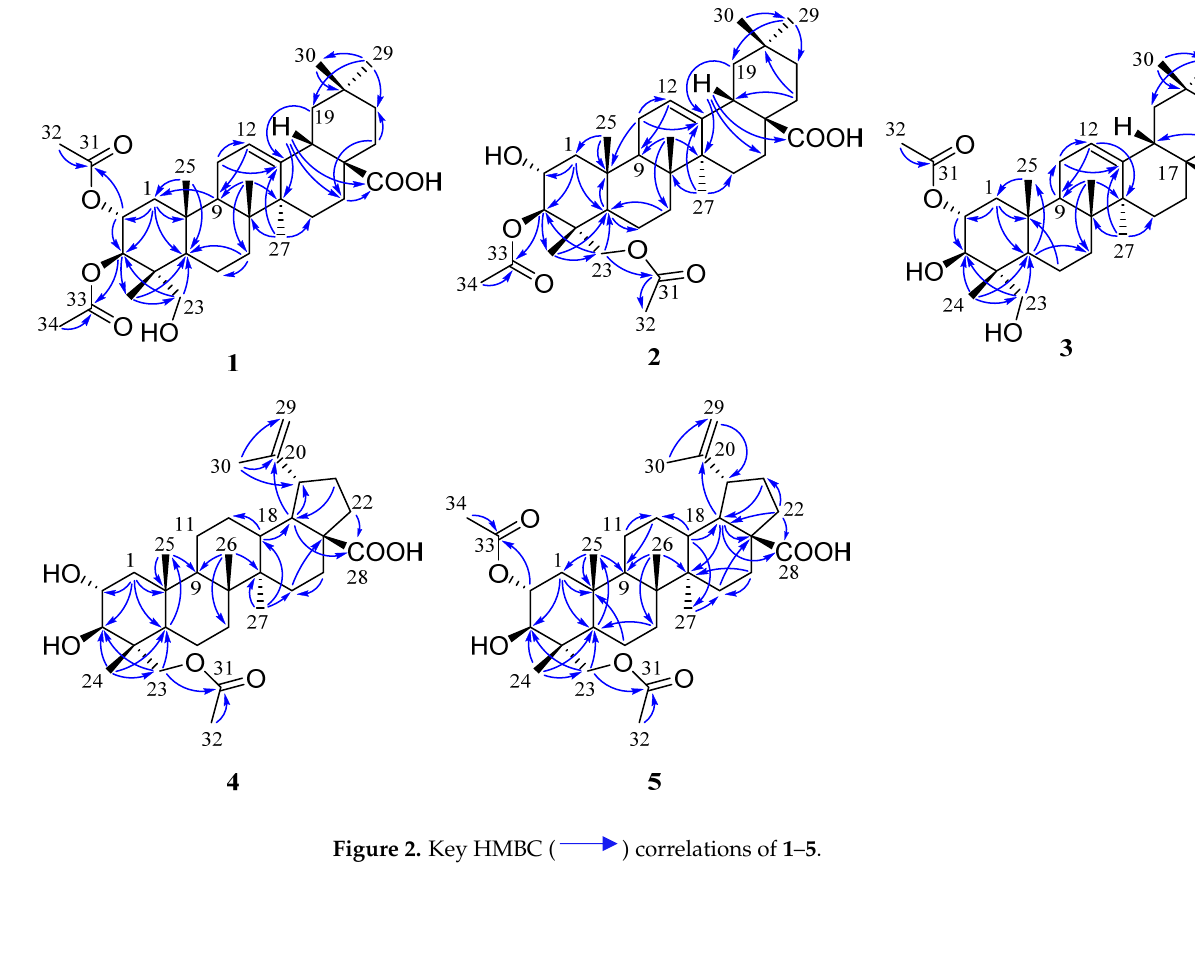
Figure 2. Key HMBC ( ) correlations of 1 – 5 .